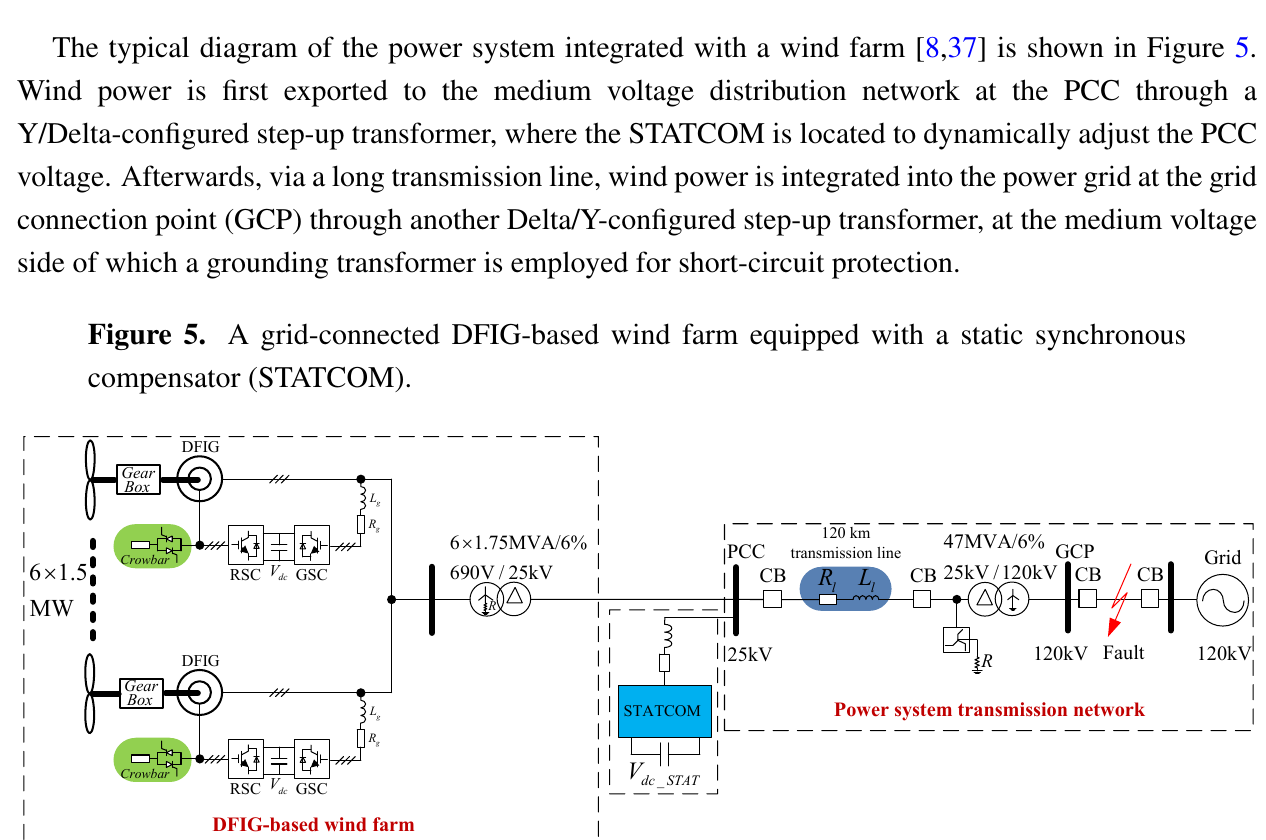
Table 3. Tolerated δ